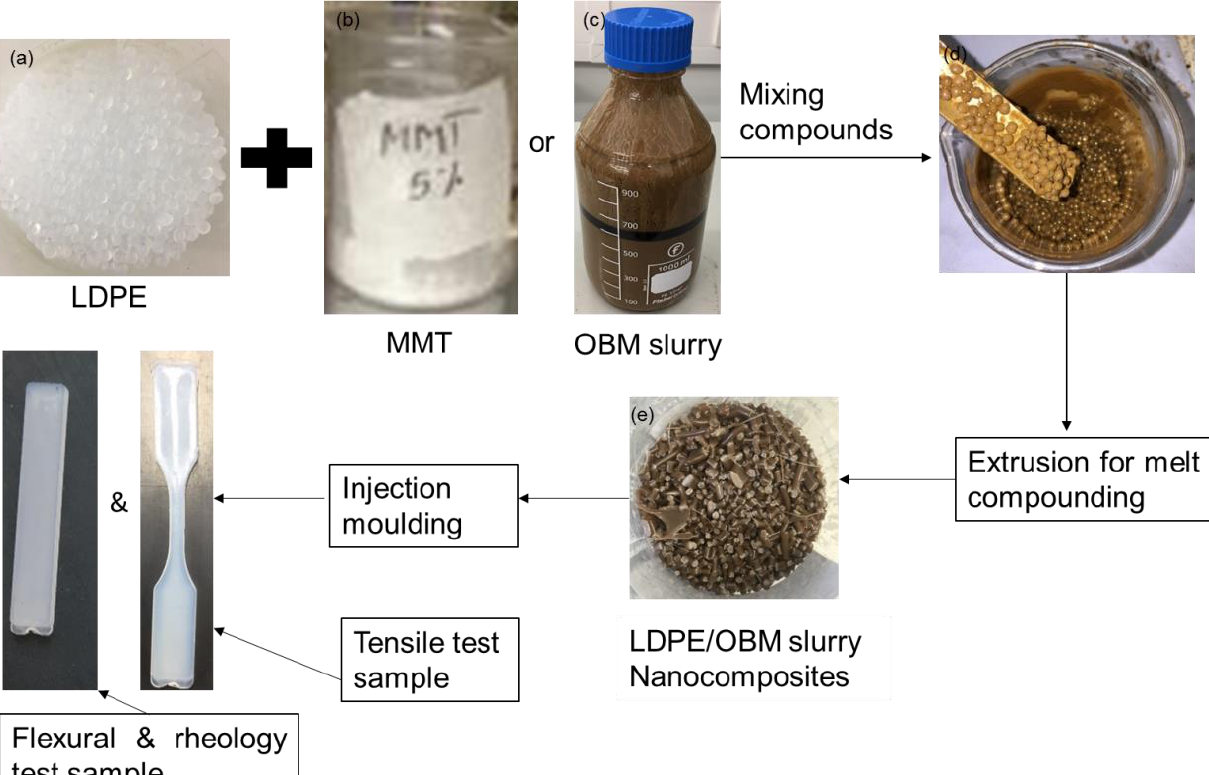
Figure 1. Flow diagram of LDPE/MMT and LDPE/OBM slurry nanocomposites sample manufacturing process.